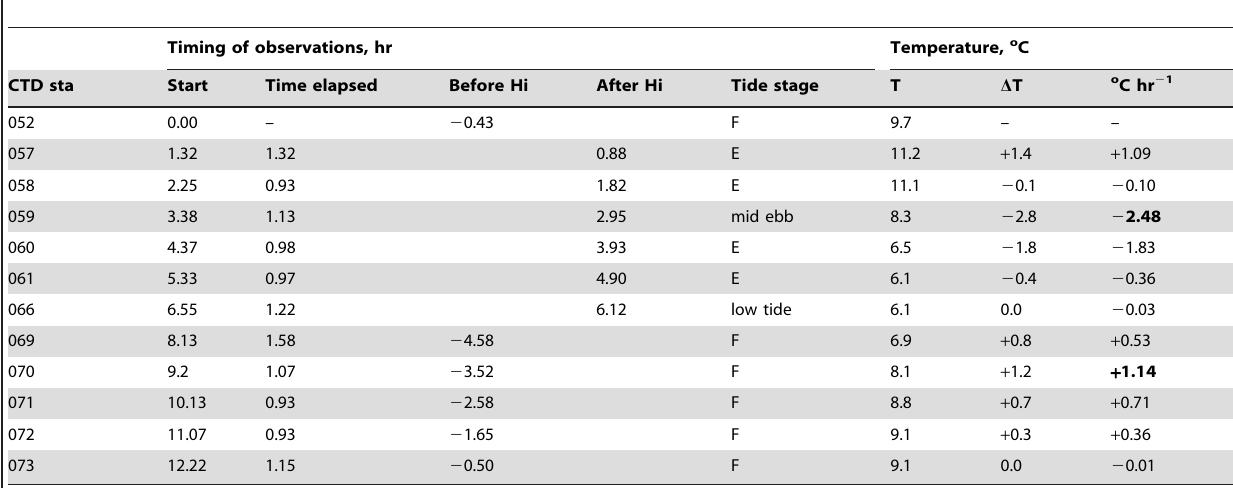
Table 4. Hourly rates of seabed temperature change at the time-series site in study area A.